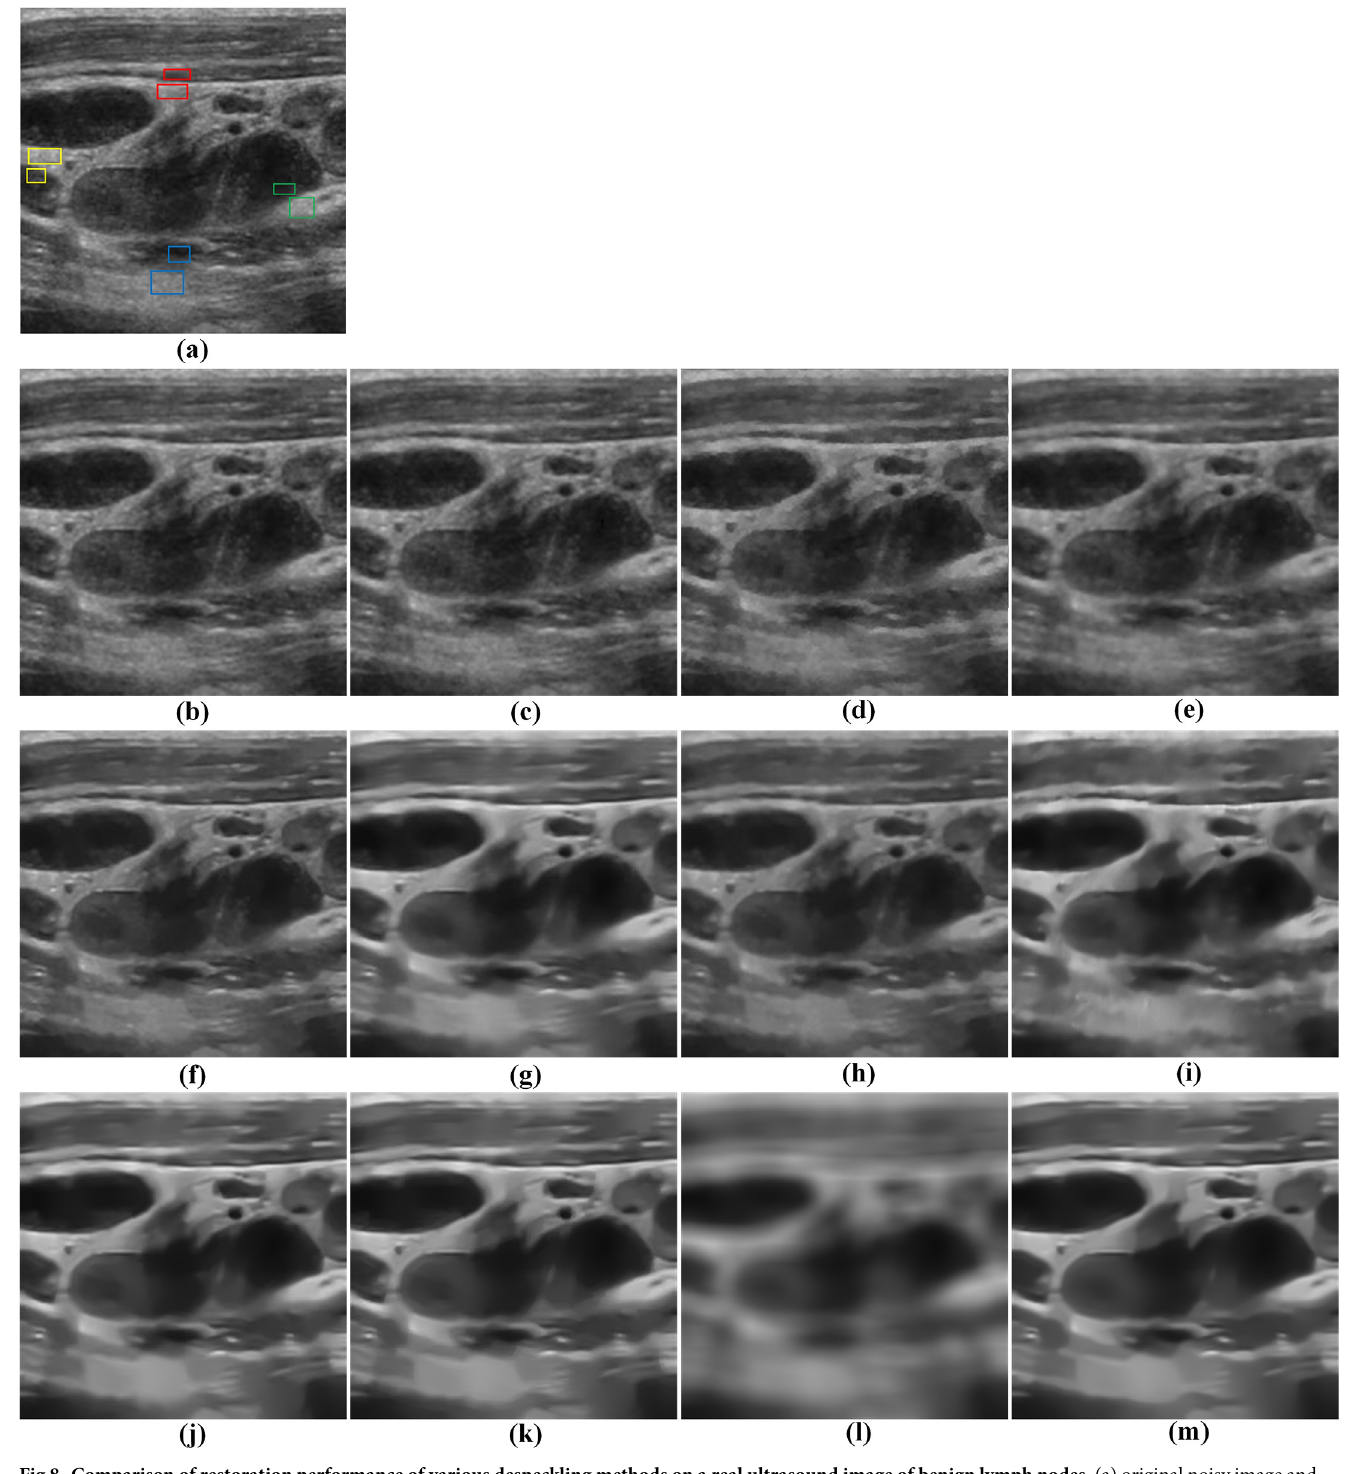
Fig 8. Comparison of restoration performance of various despeckling methods on a real ultrasound image of benign lymph nodes. (a) original noisy image and four ROIs marked with the different colors, (b) Frost filter, (c) Kuan filter, (d) SBF filter, (e) SRAD filter, (f) TNLM filter, (g) OBNLM filter, (h) NLMLS filter, (i) DnCNN filter, (j) OPCA-NLM filter, (k) RPCA-NLM filter, (l) SPCA-NLM filter, and (m) PPCA-NLM filter.